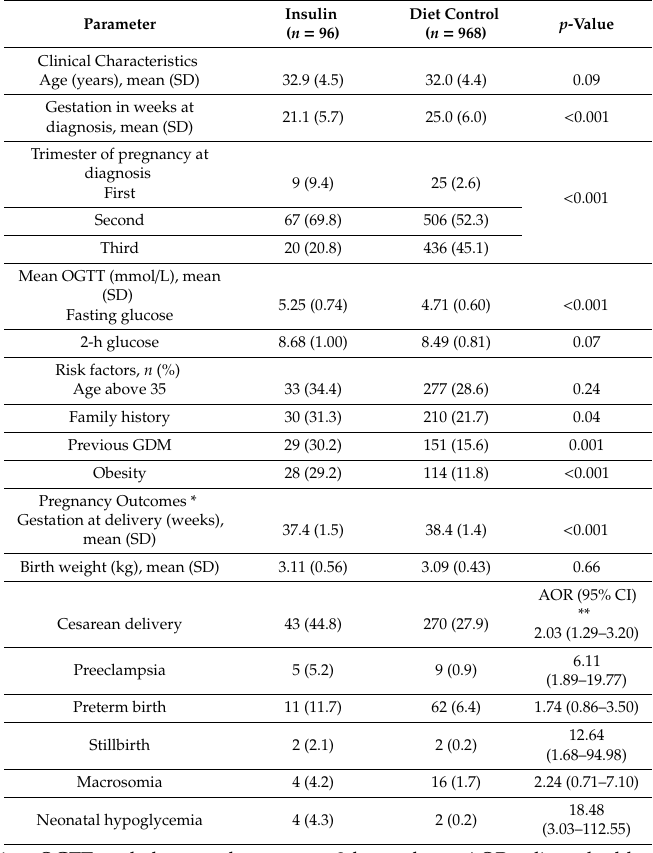
Table 3. Comparison of clinical characteristics and pregnancy outcomes of gestational diabetes mellitus (GDM) women on insulin vs. diet therapy.